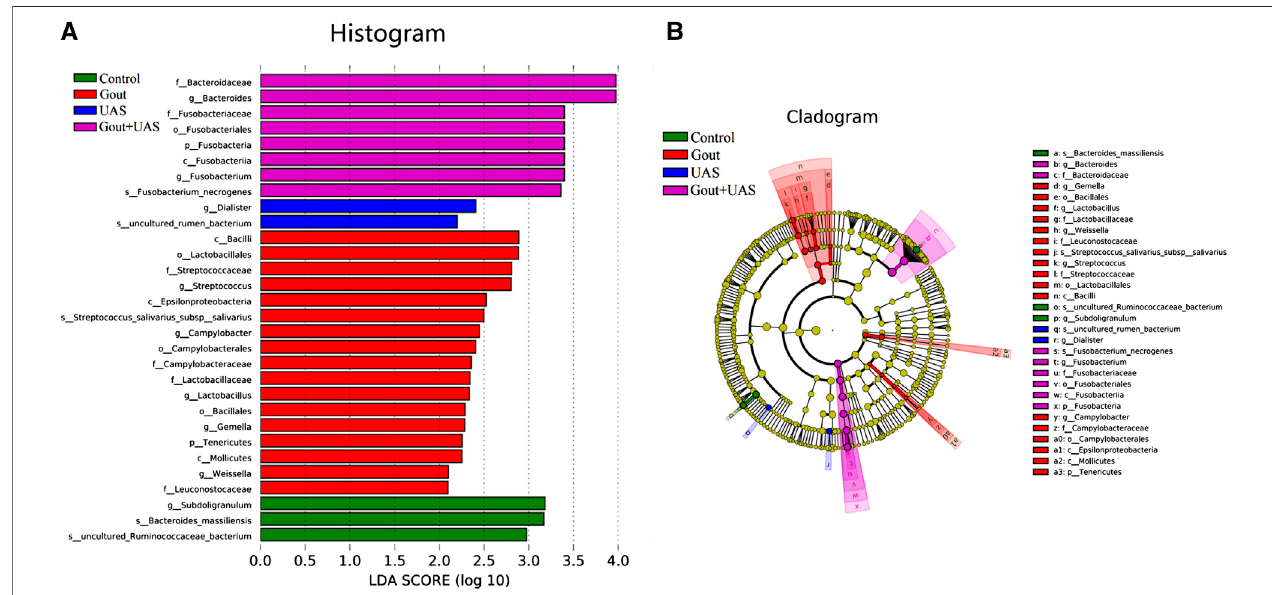
FIGURE 3 | Histogram (A) and cladogram (B) of Linear discriminant analysis effect size (LEfSe) analysis based on OTUs characterizes microbiota among the controls, Gout patients, UAS patients and Gout + UAS patients.